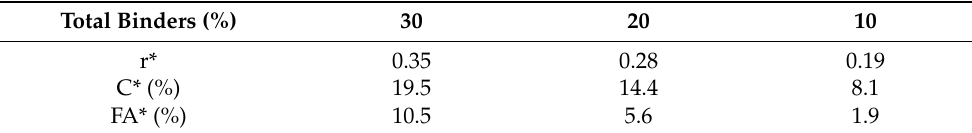
Table 7. Fly ash replacement ratio.